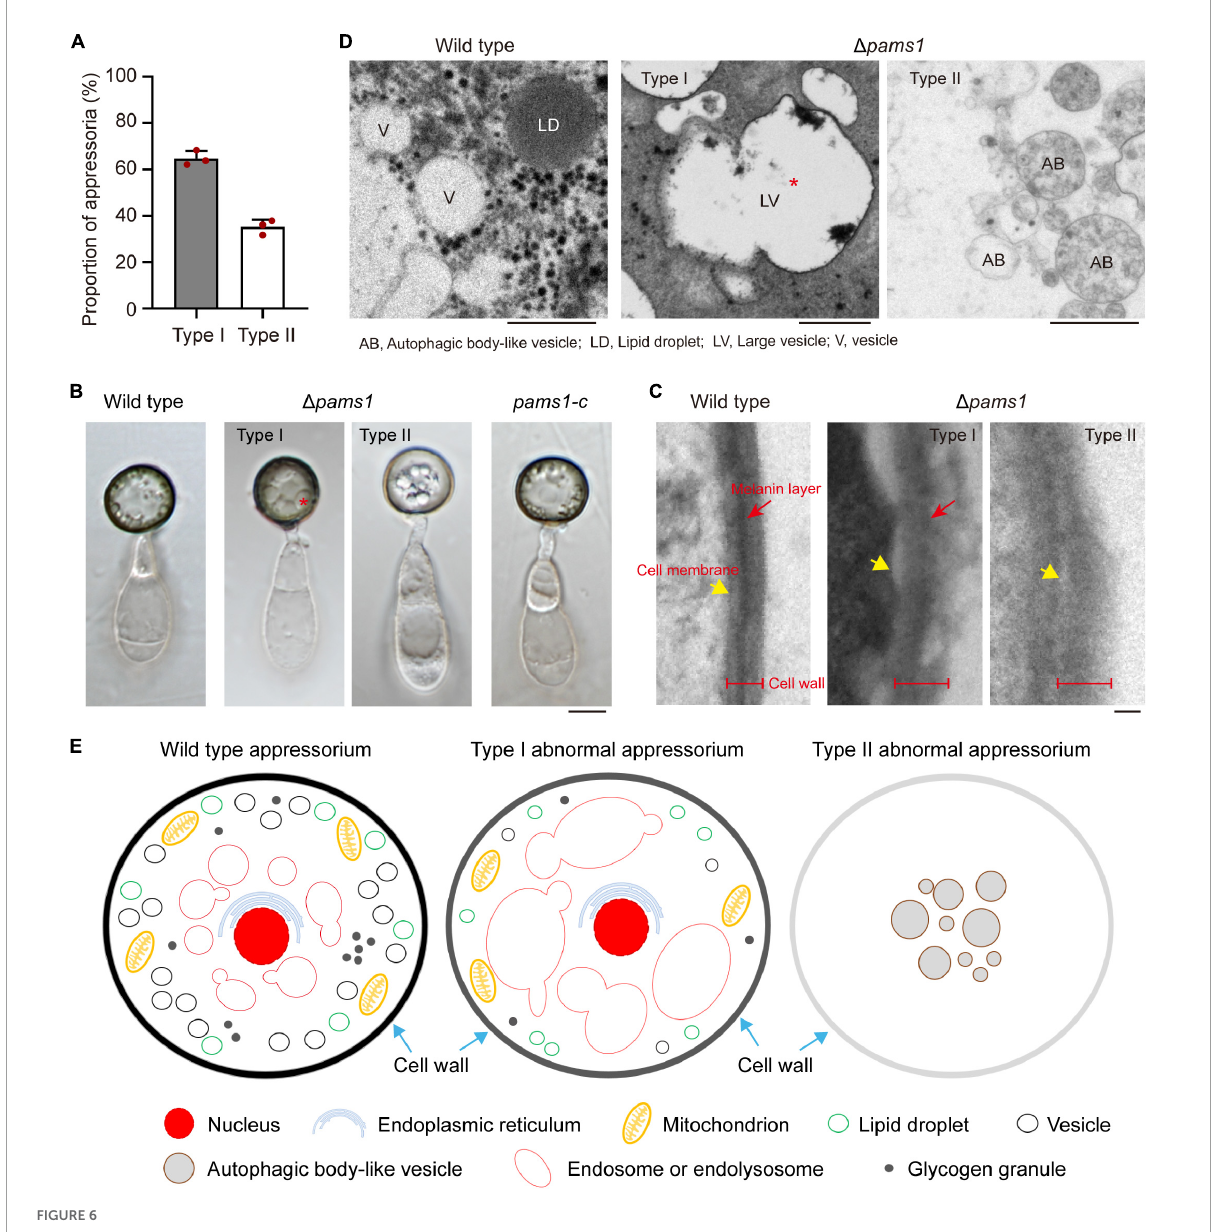
FIGURE6 (cid:49) pams1 formed two types of abnormal appressoria. (A) Proportions between the two types of abnormal appressoria on plastic coverslips at 24 hpi ( n = 3). At least 200 appressoria were counted per replicate. (B) Appressoria of (cid:49) pams1 , its complementation strain pams1-c , and the wild type at 24 hpi. (cid:49) pams1 formed two types of abnormal appressoria (types I and II). Scale bar, 5 µ m. (C) Ultrastructure of the appressorial cell wall. Scale bar, 100 nm. (D) Ultrastructure of appressorial vesicles. Scale bars, 1 µ m. (E) Schematic diagram of three types of appressoria